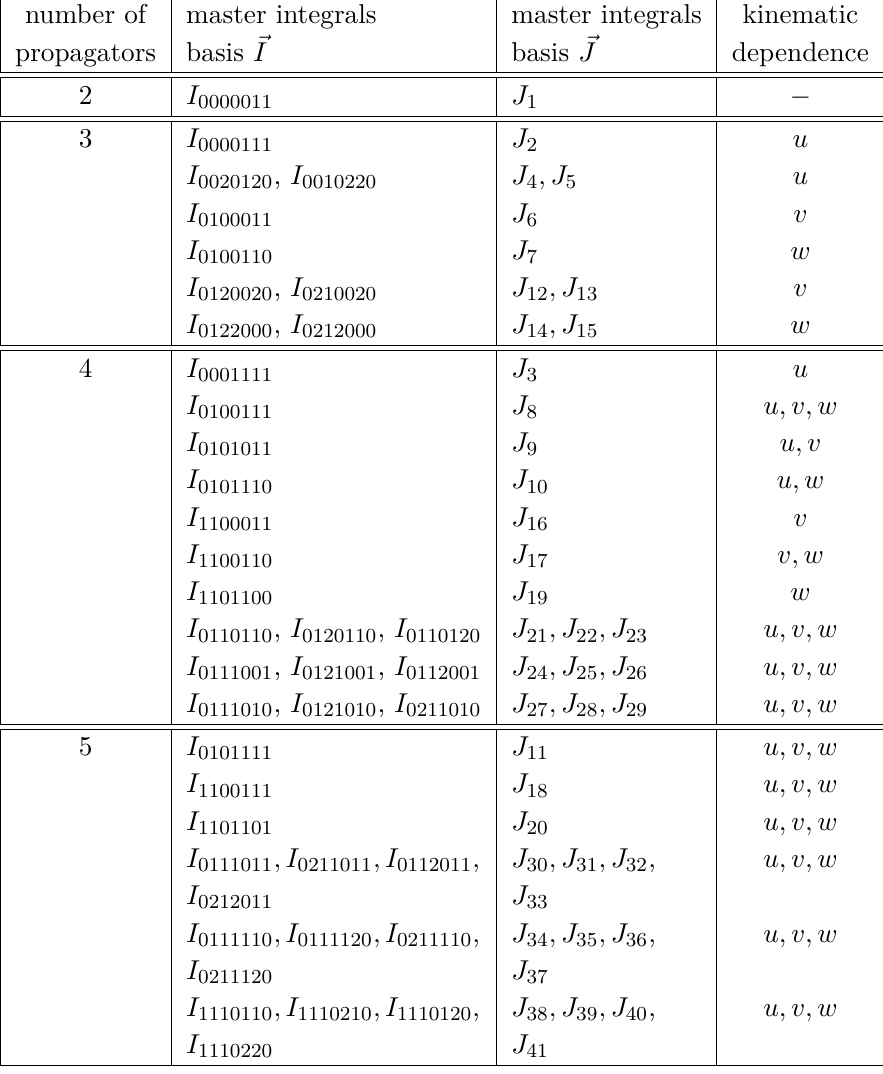
Table 1 . Overview of the set of master integrals for two-loop triangle diagrams in H → ZZ ∗ decay. The first column gives the number of non-zero propagators which appear in the master integrals, the second column lists the master integrals in the basis ~I , the third column lists corresponding master integrals in the basis ~J . The last column gives the kinematic dependence of master integrals in terms of dimensionless quantities defined in equation (2.4). system. Our canonical basis ~J , in terms of dimensionless quantities u, v and w , is given by the following